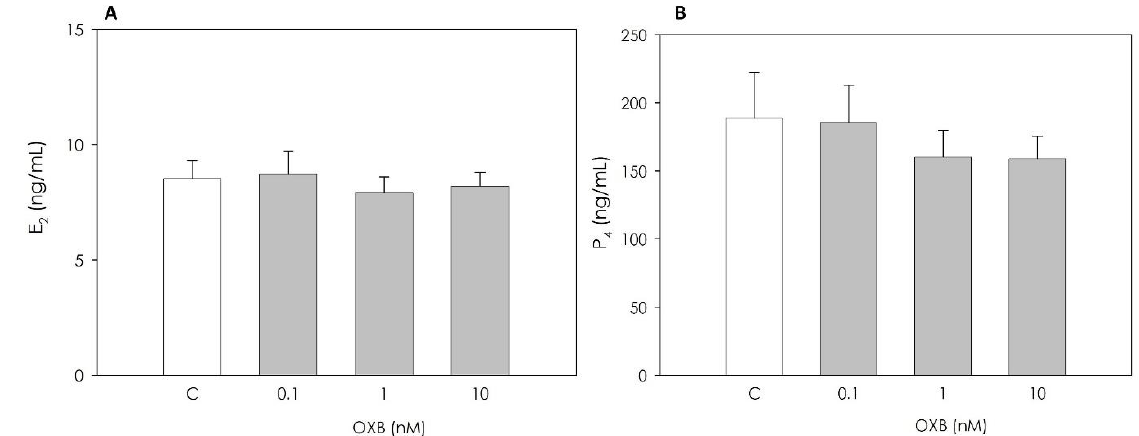
Figure 3. Effect of the 48 h treatment with orexin B (OXB; 0.1, 1 and 10 nM) on swine granulosa cell estradiol 17β (E2) and progesterone (P4) production (panels ( A ) and ( B ), respectively) evaluated by ELISA tests. Data, expressed as ng/mL, represent the mean ± SEM of six replicates/treatment repeated in five different experiments.